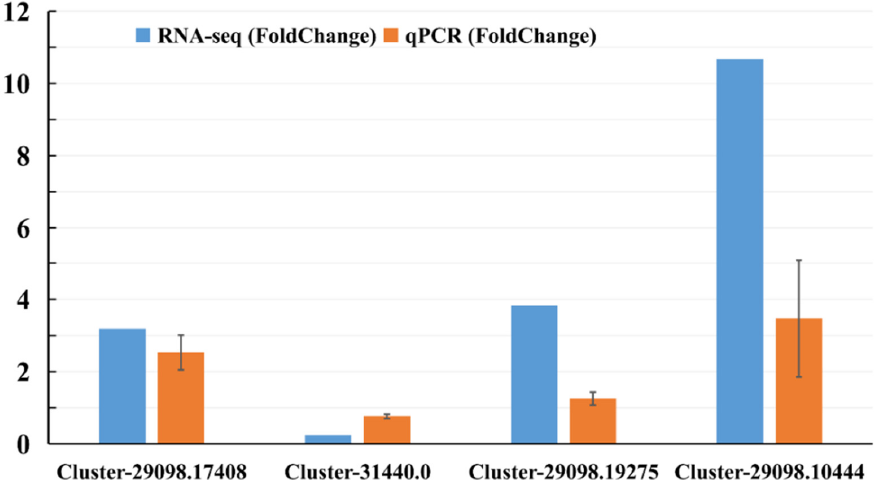
Figure 3. Gene expression levels from qPCR and RNA-seq. Orange columns represent the qPCR results, and blue columns represent the RNA-seq results. The y -axis represents the fold change in the relative expression level of the gene between the treated sample and control (HS vs. CS).